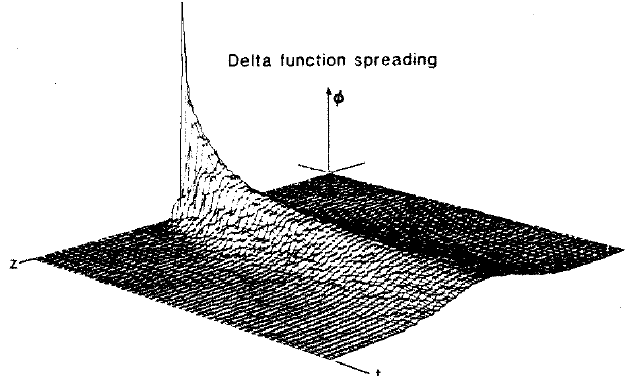
Fig. 11. Flux per unit gradient of a passive scalar. The diffusivity is evaluated by combining the observations of turbulent layers with local diffusivity estimates (Woodman and Rastogi,